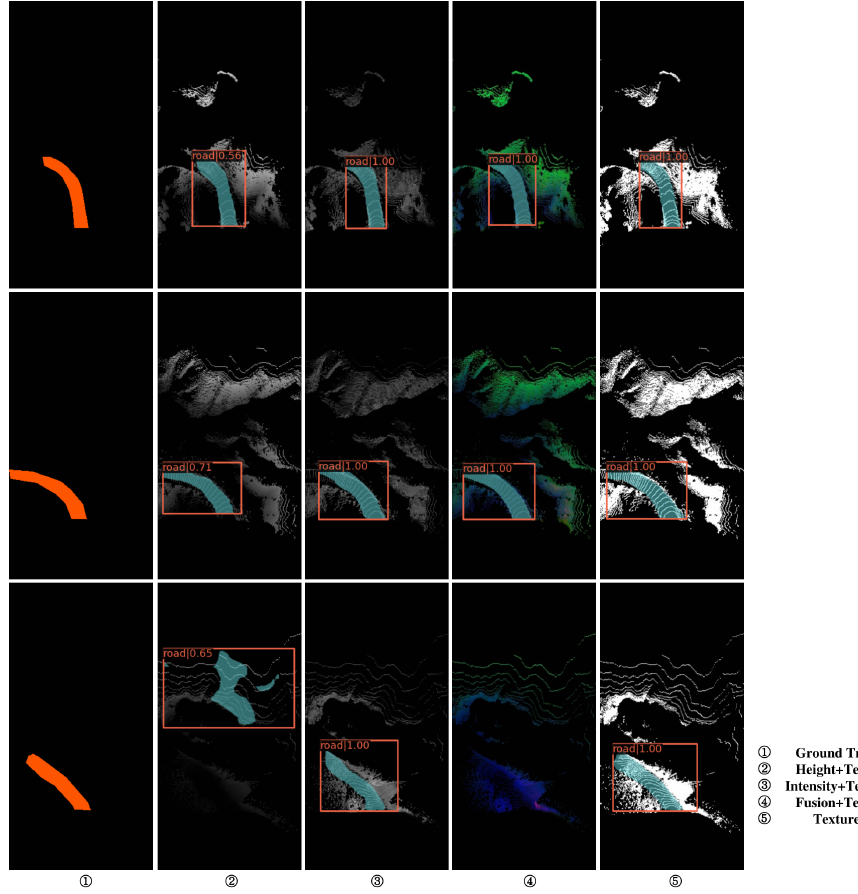
Figure 7. Display of validation set test results.